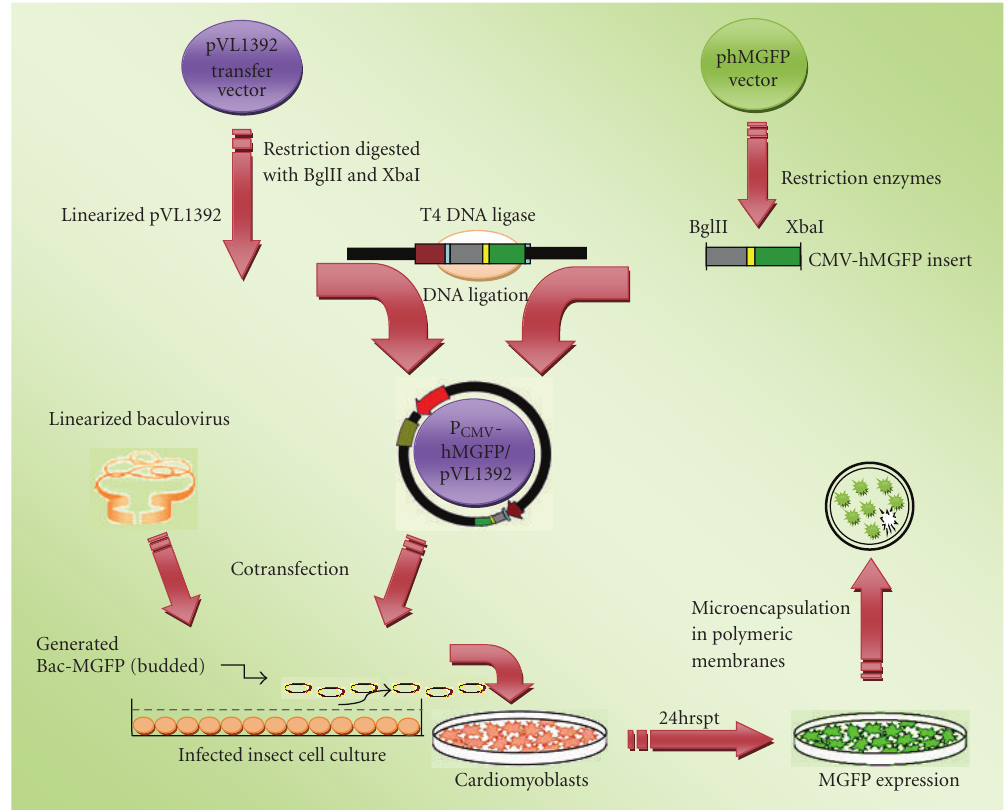
Figure 1: Schematic representation of molecular cloning strategy for generation of recombinant BacMam virus and microencapsulation of transduced cells. The reporter gene hMGFP was excised along with the CMV promoter from phMGFP vector using BglII and XbaI restriction enzymes and inserted in the MCS of the baculovirus transfer vector pVL1392 to construct the P CMV − hMGFP /pVL1392 plasmid. The BacMam viruses generated by cotransfection were transduced to the cardiomyocytes. This was followed by microencapsulation and tracking the MGFP expression of the transduced